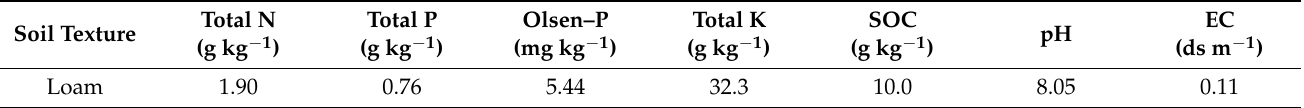
Table 1. Soil physical and chemical